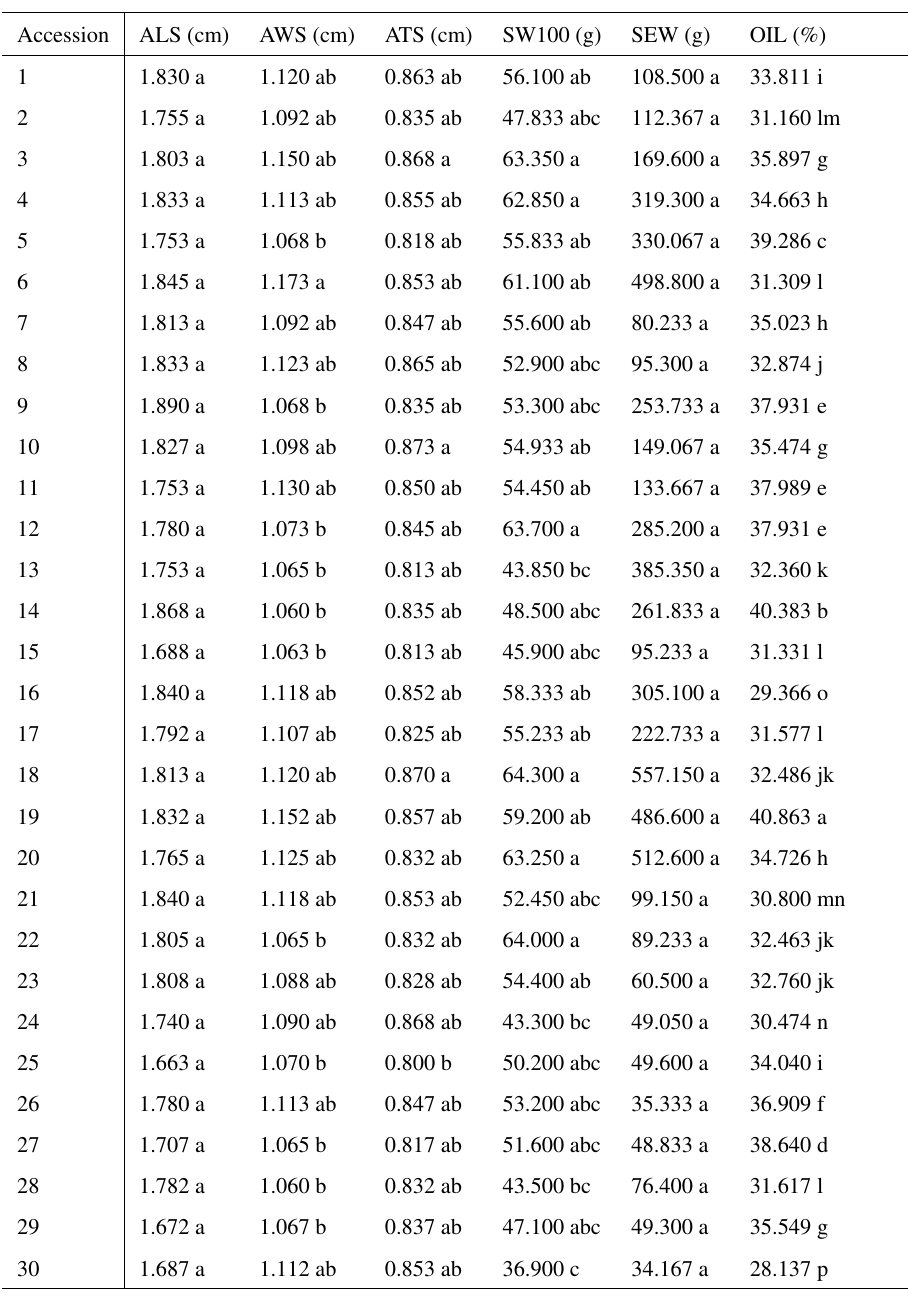
Table 5. Results of Newman Keuls'means separation test on seeds